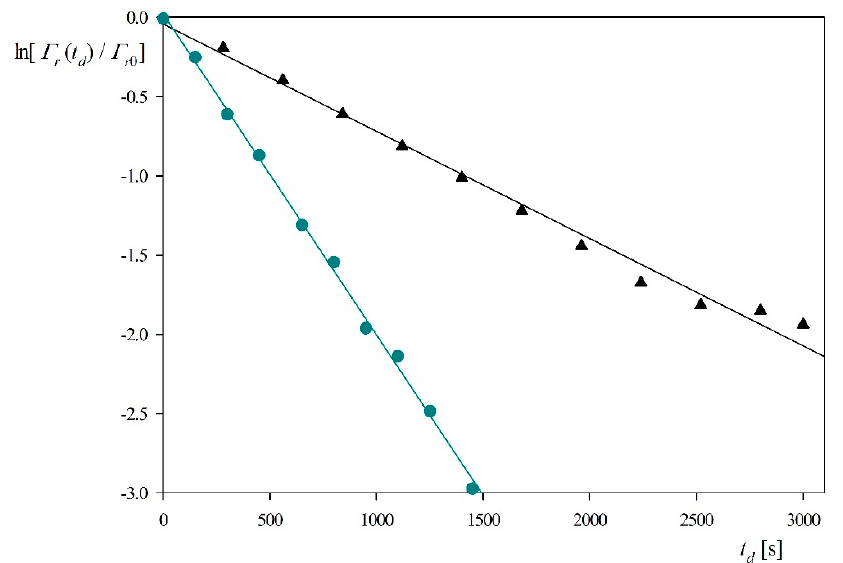
Figure 5. Myoglobin desorption kinetics derived from QCM and expressed as the dependence of ln [ Γ r ( t d ) / Γ r 0 ] on the desorption time t d ; silica sensor, pH 3.5 (triangles), pH 4 (circles), NaCl concentration 0.01 M, flow rate 2.5 × 10 − 3 cm 3 s − 1 . The lines represent linear fits of experimental data.